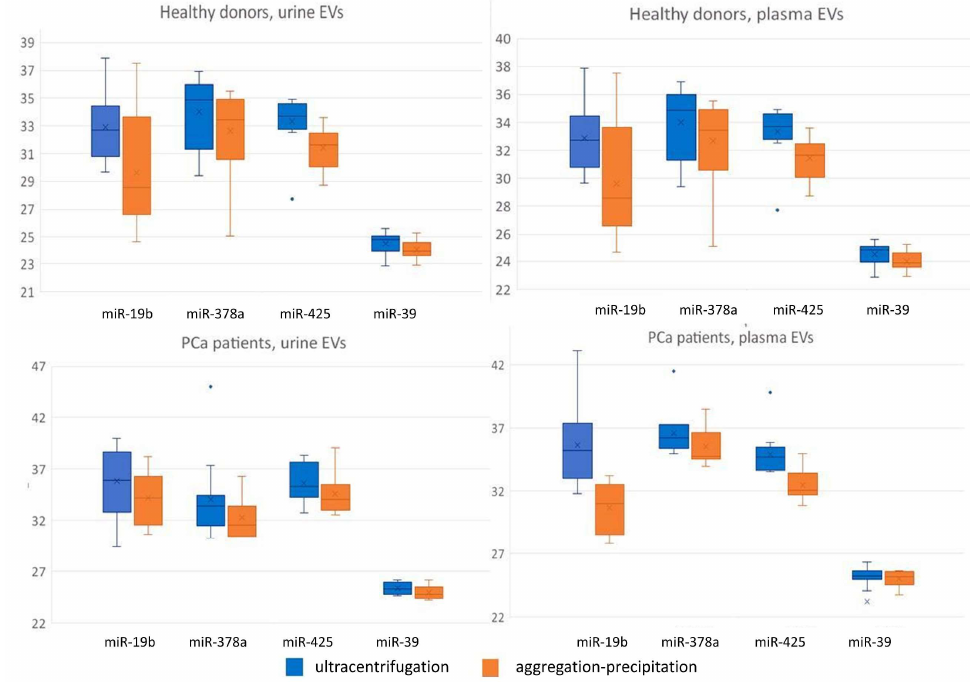
Figure 5. Mir-19b, miR-378a, miR-425, and cel-miR-39 Cp values isolated from the urine and plasma extracellular vesicles of healthy donors and PCa patients.